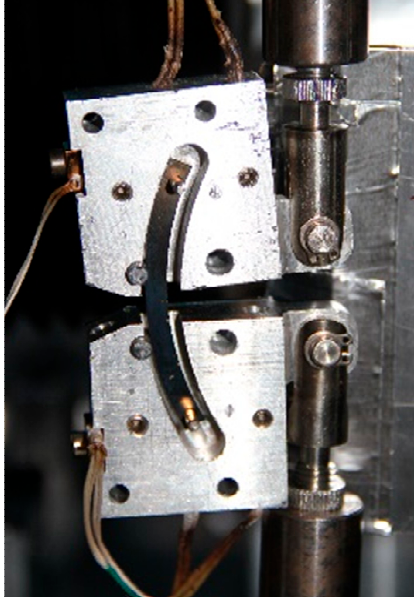
Figure 5. Sample holder constructed by CNEA, Buenos Aires, for a mechanical load machine to perform tensile tests at higher temperatures.